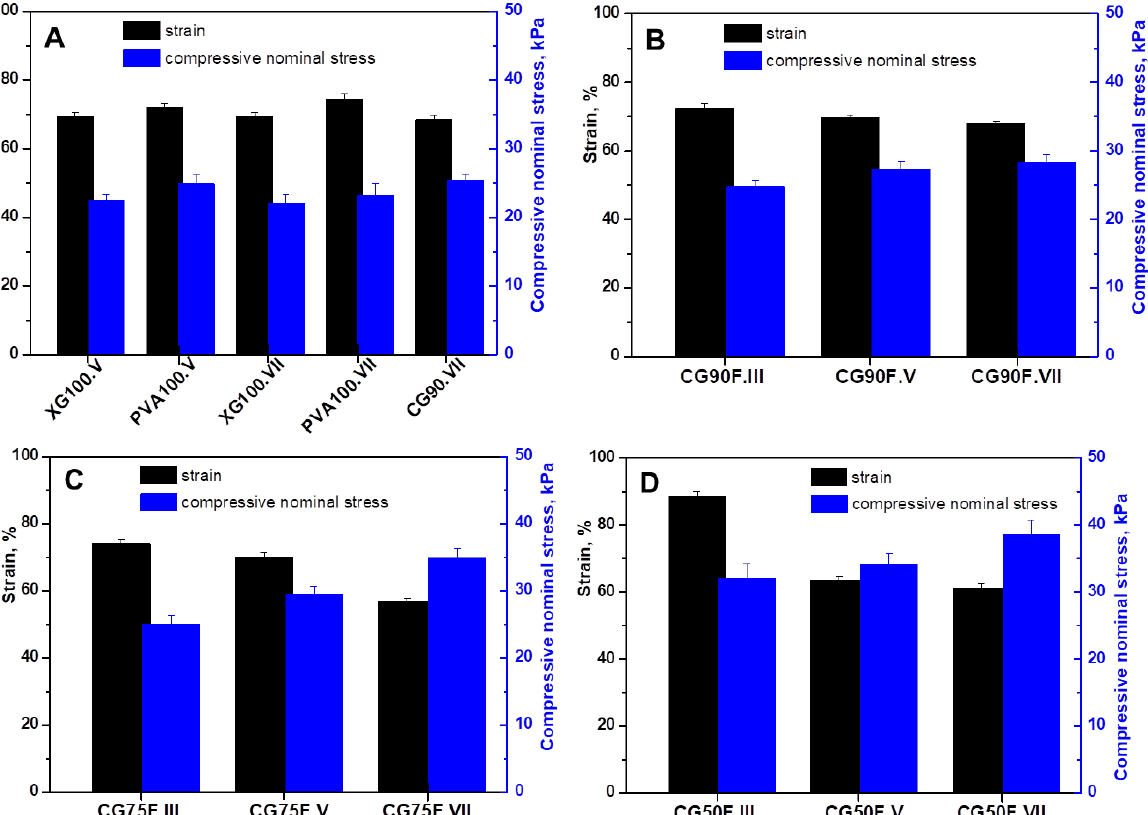
Figure 2. Maximum sustained compression (black color) and compressive strength (blue color): ( A ) control samples; ( B ) composite hydrogels prepared with a weight ratio between XG and PVA of 9:1; ( C ) composite hydrogels prepared with a weight ratio between XG and PVA of 3:1; ( D ) composite hydrogels prepared with a weight ratio between XG and PVA of 1:1. All the data were expressed as the mean of three individual measurements ± SD. The SD is presented as error bars.